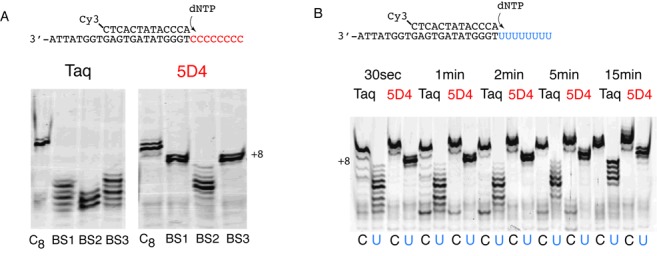
Sulphonate conversion and template base effects on polymerase activity. (A) Activity of Taq polymerase and 5D4 polymerase in copying a polyC (dC8) (Template T2, 5 min extension) either unmodified and bisulfite-treated and desulphonated using two different approaches (BS1, 3) or not desulphonated (BS2). Only 5D4 can successfully bypass the bisulfite-treated polyC stretch and generate full length (+8) product but only after (at least partial) desulphonation. (B) Comparison of polymerase activity of Taq and 5D4 on a dC8 (T2) compared to a dU8 (T3) template for different extension times (0.5–15 min). Clearly, dU is a poor template base for Taq polymerase. Please note that dU8 and dC8 template extension products (dA8 and dG8) display slightly different mobility in a 20% urea-polyacrylamide gel due to the different base compositions as can also be seen in Figure 1B and C.